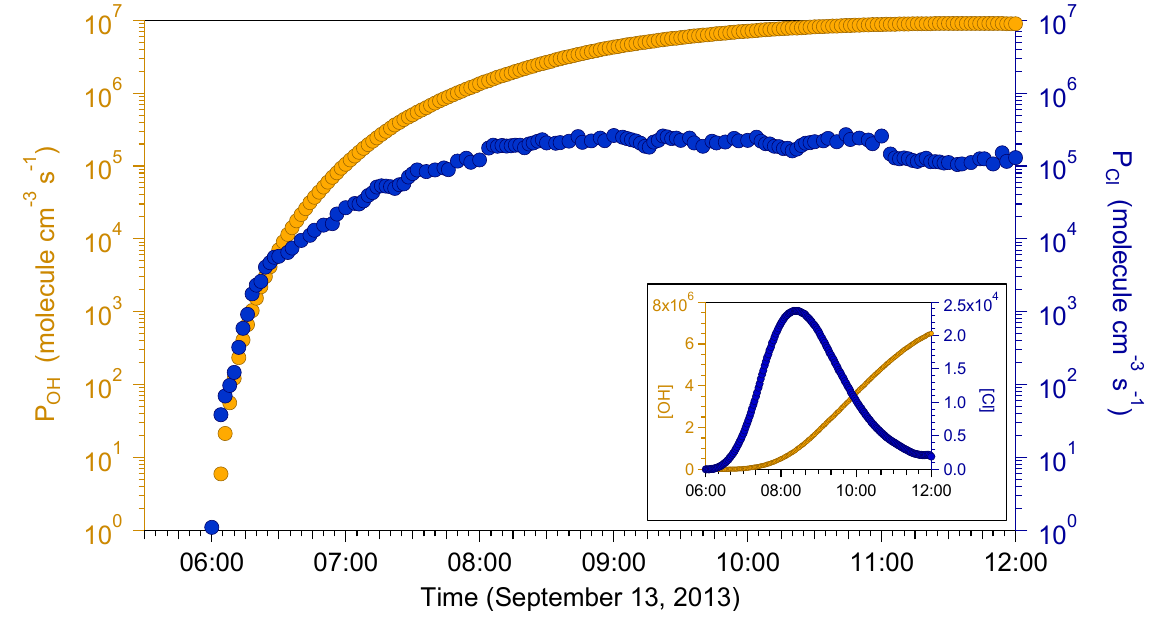
Figure 7. OH • production resulting from the photolysis of O 3 compared to Cl • production from observed concentrations of ClNO 2 on the morning of 13 September 2013. The inset